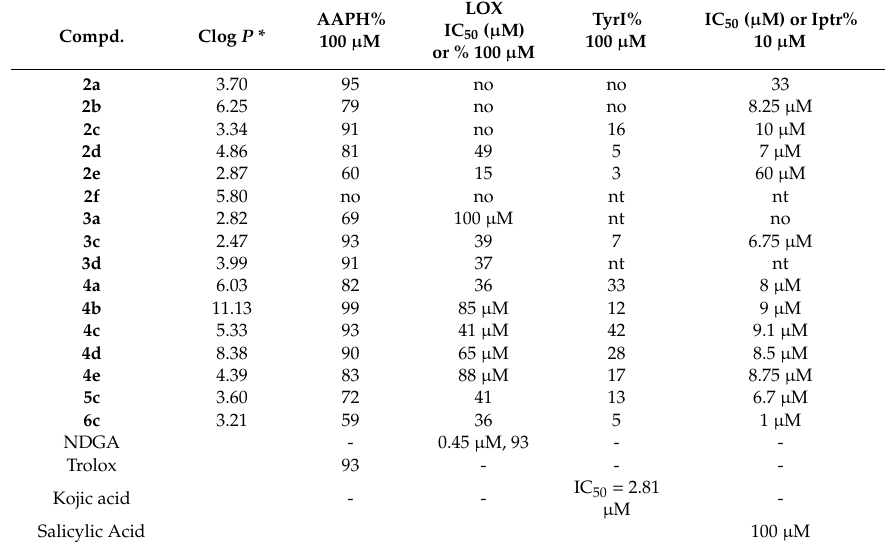
Table 1. Theoretically calculated clog P values; Anti-lipid peroxidation (AAPH); In vitro lipoxygenase (LOX) inhibitory activity (IC 50 ( µ M) or % (100 µ M)); In vitro inhibition of mushroom tyrosinase (Tyr)—(TyrI% (100 µ M)); In vitro inhibition of trypsin induced proteolysis (IC 50 ( µ M) or %